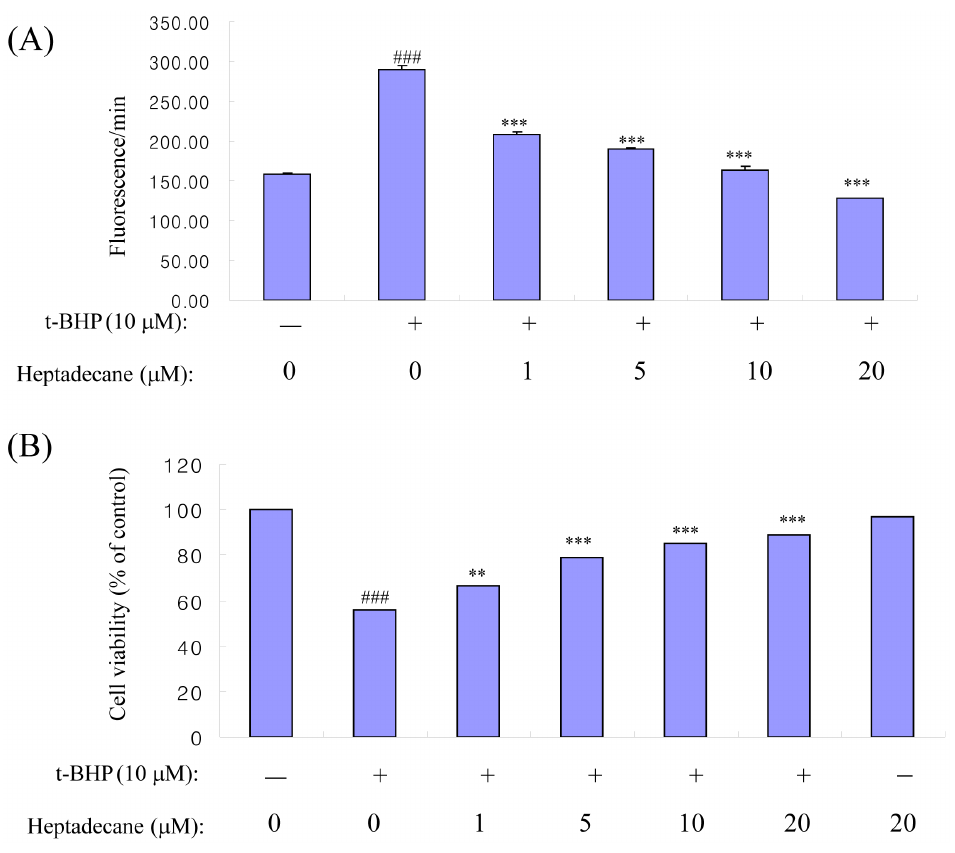
Figure 4. Heptadecane protected YPEN-1 cells from t-BHP-induced oxidative stress and cytotoxicity. (A) Cells were treated with or without/heptadecane at concentrations of 1, 5, 10, and 20 m M for 1 hr and then with vehicle or 10 m M t-BHP. (B) Cells were treated with or without heptadecane at concentrations of 1, 5, 10 and 20 m M for 1 hr and then with t-BHP (10 m M) for 6 hr. Viable cell numbers were determined using an MTT assay. ## p , 0.01 vs. vehicle treated control group; **p , 0.01, ***p , 0.001 vs. the 10 m M t-BHP group by one-factor ANOVA.